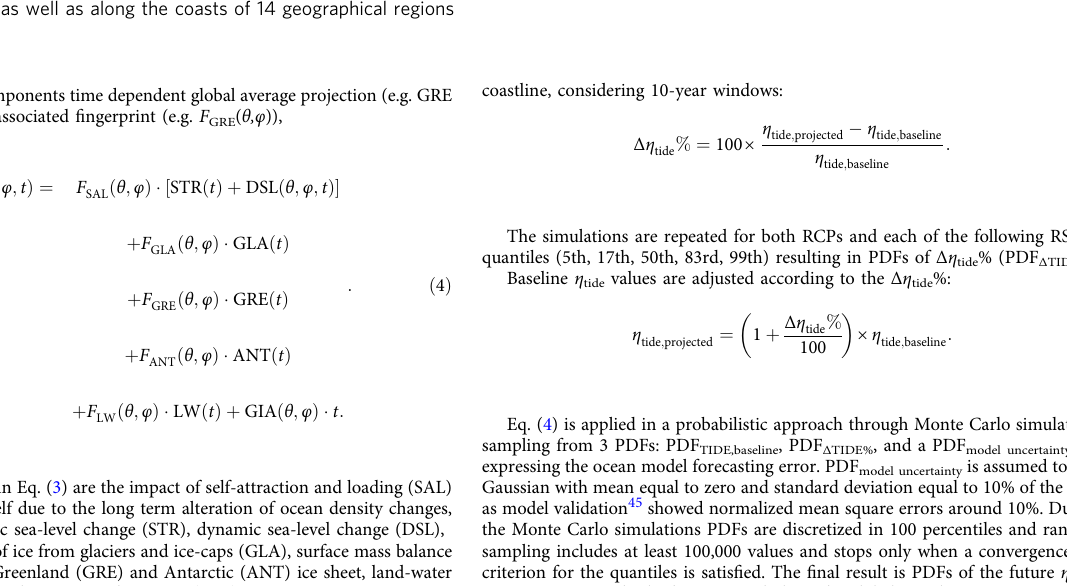
Fig. 9 Future frequency of the present day 100-year ESL along 14 geographical regions. Return period of the present day 100-year ESL under RCP4.5 and RCP8.5 in 2050 ( a ) and 2100 ( b ). Colored boxes express the median and colored patches the 5 and 95% quartiles. The values shown are averages along the global coastline as well as along the coasts of 14 geographical